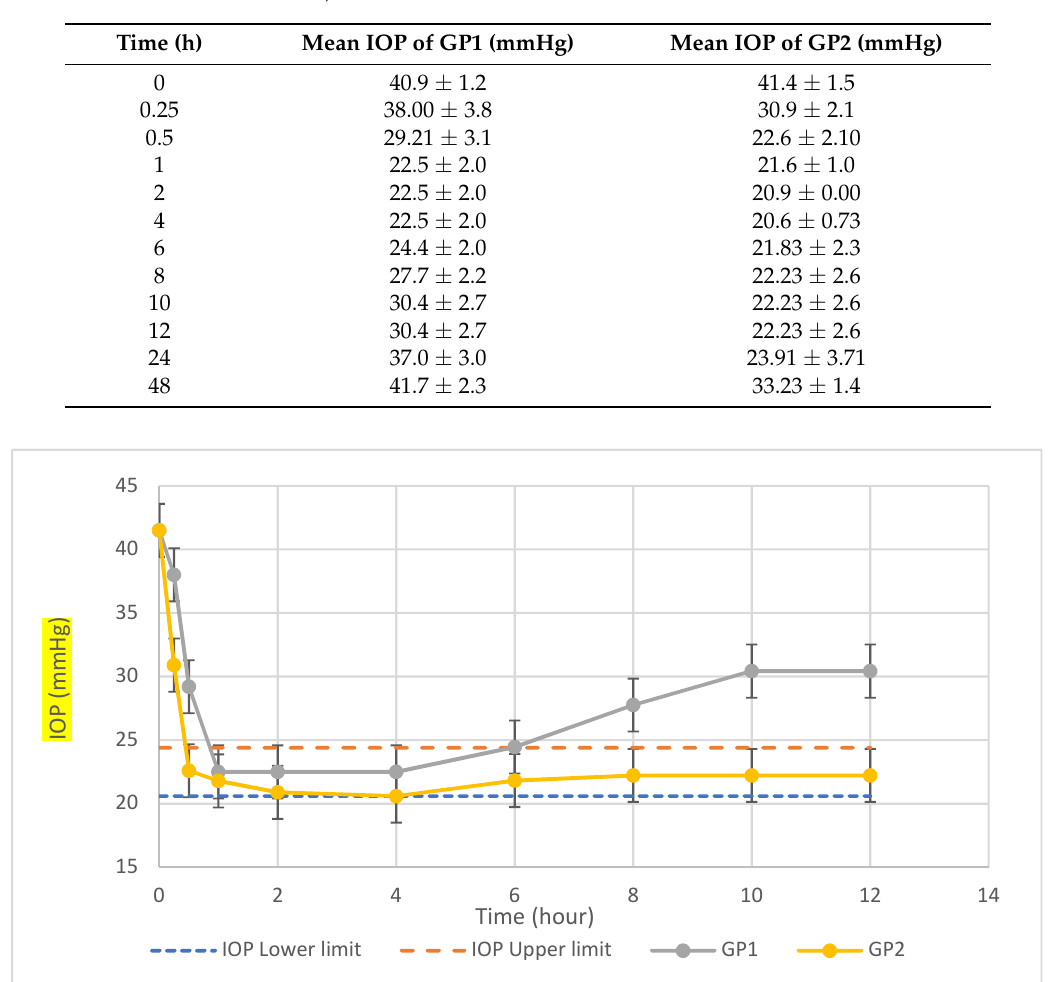
Figure 4. Mean IOP of hypertensive rabbits for first 12 h with different administration in comparison with physiological minimum IOP for rabbit (IOP lower limit) and physiological maximum (IOP upper limit).